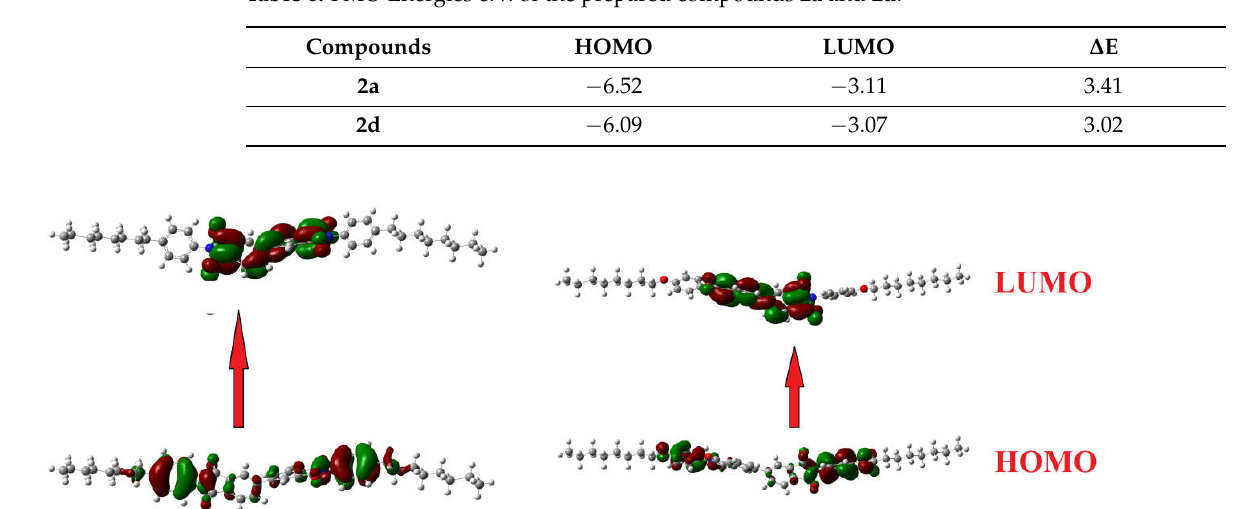
Table 6. FMO Energies e.V. of the prepared compounds 2a and 2d .